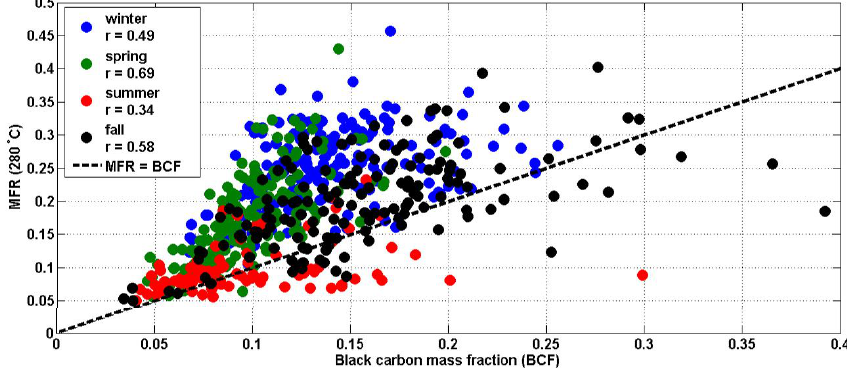
Fig. 7. Mass fraction remaining (MFR) at 280 ◦ C as a function of BC mass fraction during different seasons. A clear correlation is observed during winter, spring and fall months (p-value < 10 − 5 ) . The black line describes the situation where the entire non-volatile aerosol mass (at 280 ◦ C in 1.2s) may be due to BC. The existence of measurement points below this line most likely arise from the attribution of all PM 2 . 5 BC to sub-500nm